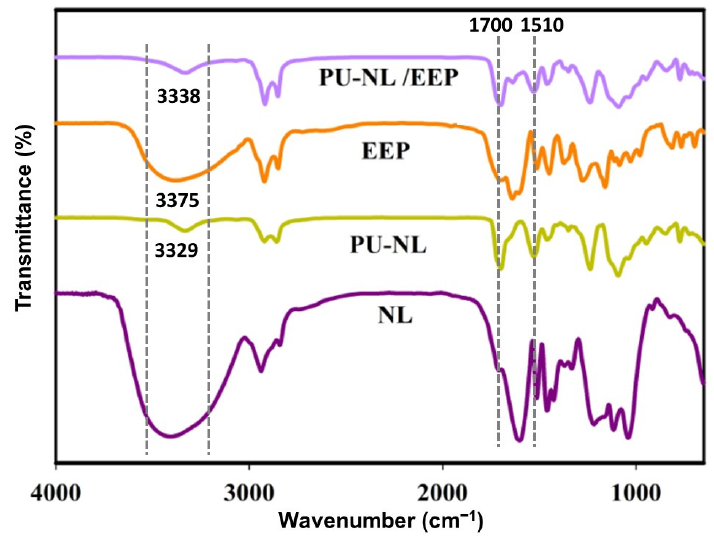
Figure 2. The FTIR spectra of NL, PU-NL, EEP, and PU-NL/EEP.